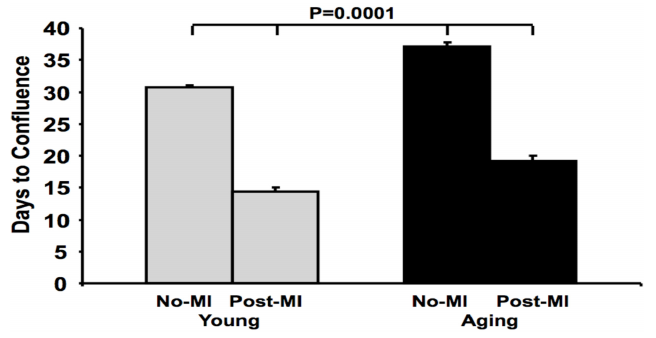
Figure 1. Explants from aging hearts grow more slowly. Explants from hearts of aging mice grow to confluence in vitro more slowly both at baseline and after MI. The aging hearts retain some ability to increase the explant outgrowth rate.